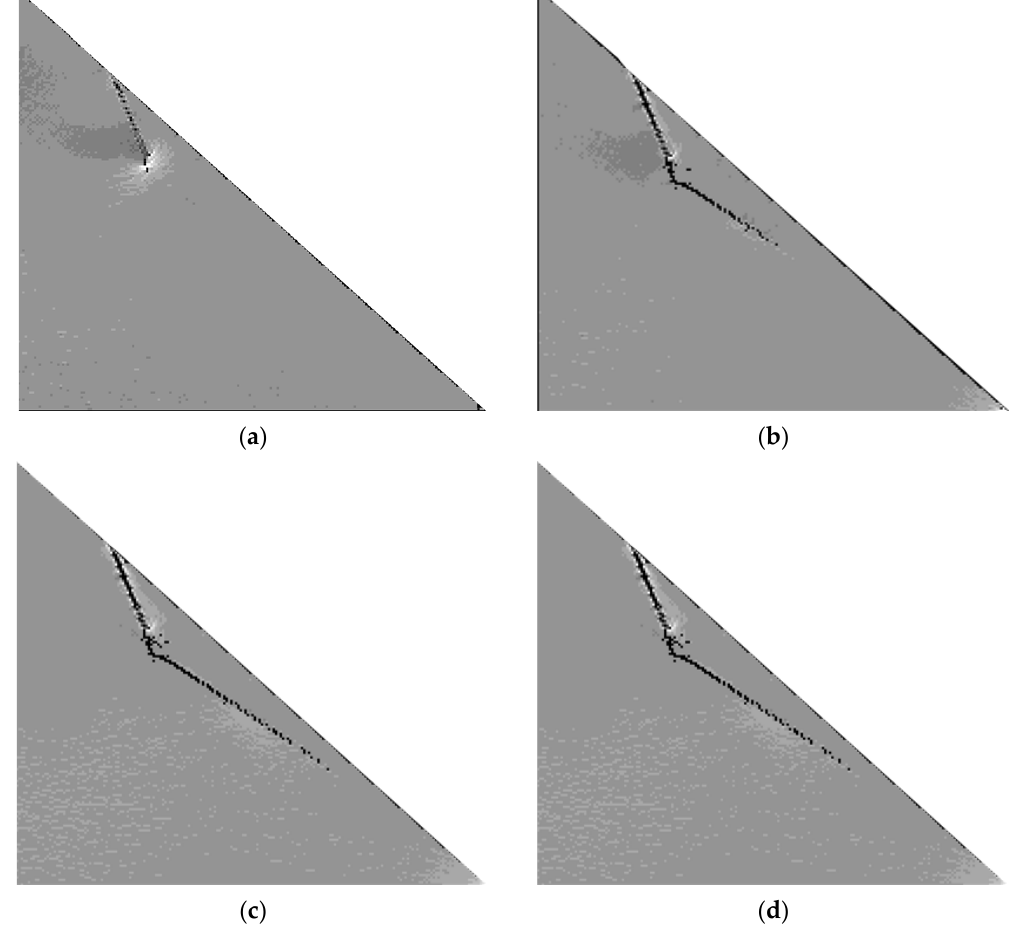
Figure 12. Minimum principal stress distributions under different freezing rates: ( a ) freezing rate = 25%, σ 3 = − 6.18~4.51 MPa; ( b ) freezing rate = 50%, σ 3 = − 8.27~5.98 MPa; ( c ) freezing rate = 75%, σ 3 = − 10.9~9.06 MPa; ( d ) freezing rate = 100%, σ 3 = − 13.6~10.08 MPa.